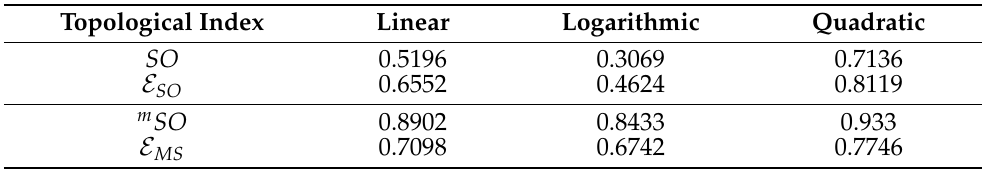
Table 6. The coefficient of determination of the boiling points with the topological indices SO , E SO , m SO , and E MS for the linear, logarithmic, and quadratic